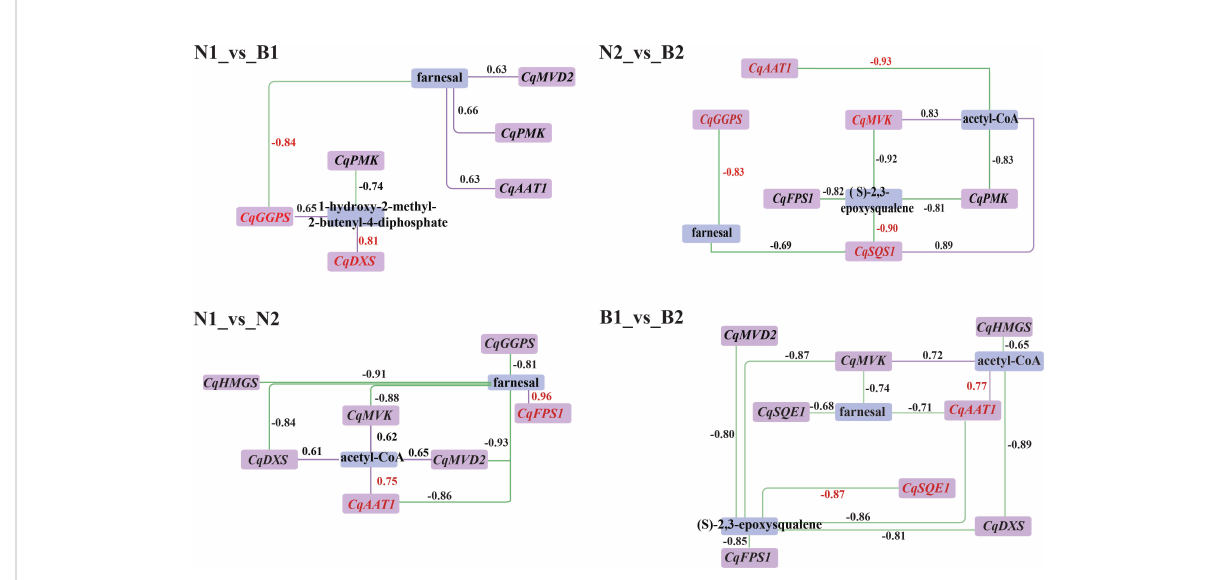
FIGURE 4 Correlation analysis between the candidate differentially expressed genes (DEGs) and differentially accumulated metabolites (DAMs). Purple and blue rectangles indicate the DEGs and DAMs associated with the biosynthesis of triterpenoid saponin (TS), respectively. The labels above the rectangle indicate the speci fi c names of DEGs and DAMs. The purple solid lines and green dashed lines indicate positive correlation and negative correlation between DEGs and DAMs in the above four comparison. The numbers represent the correlation values, where the correlation coef fi cients and gene names are highlighted in red for the key DEGs and